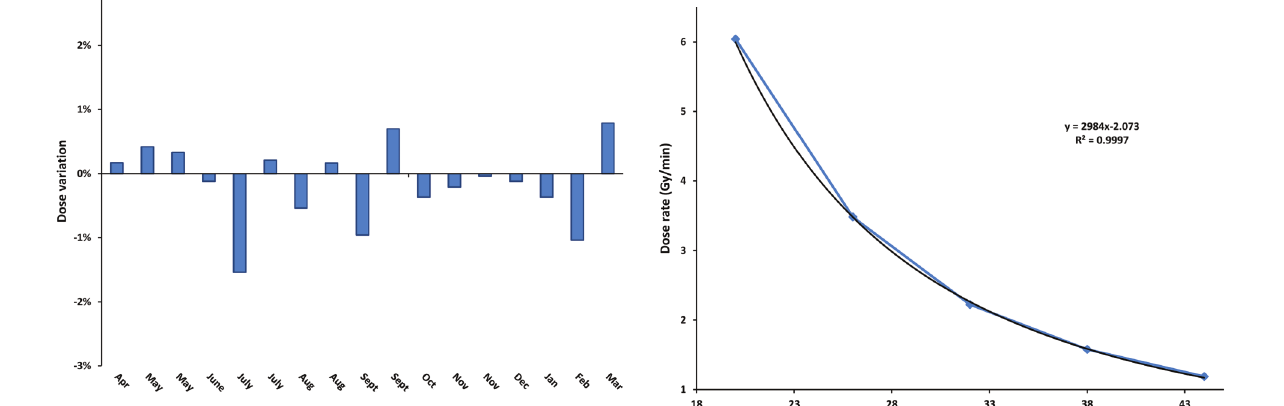
Figure 4. Variation of dose rates during 1 year. The data were obtained by the constancy evaluation in this period. Table 1. Repeatability of dose measurements using the ionization chamber (during 1 min).